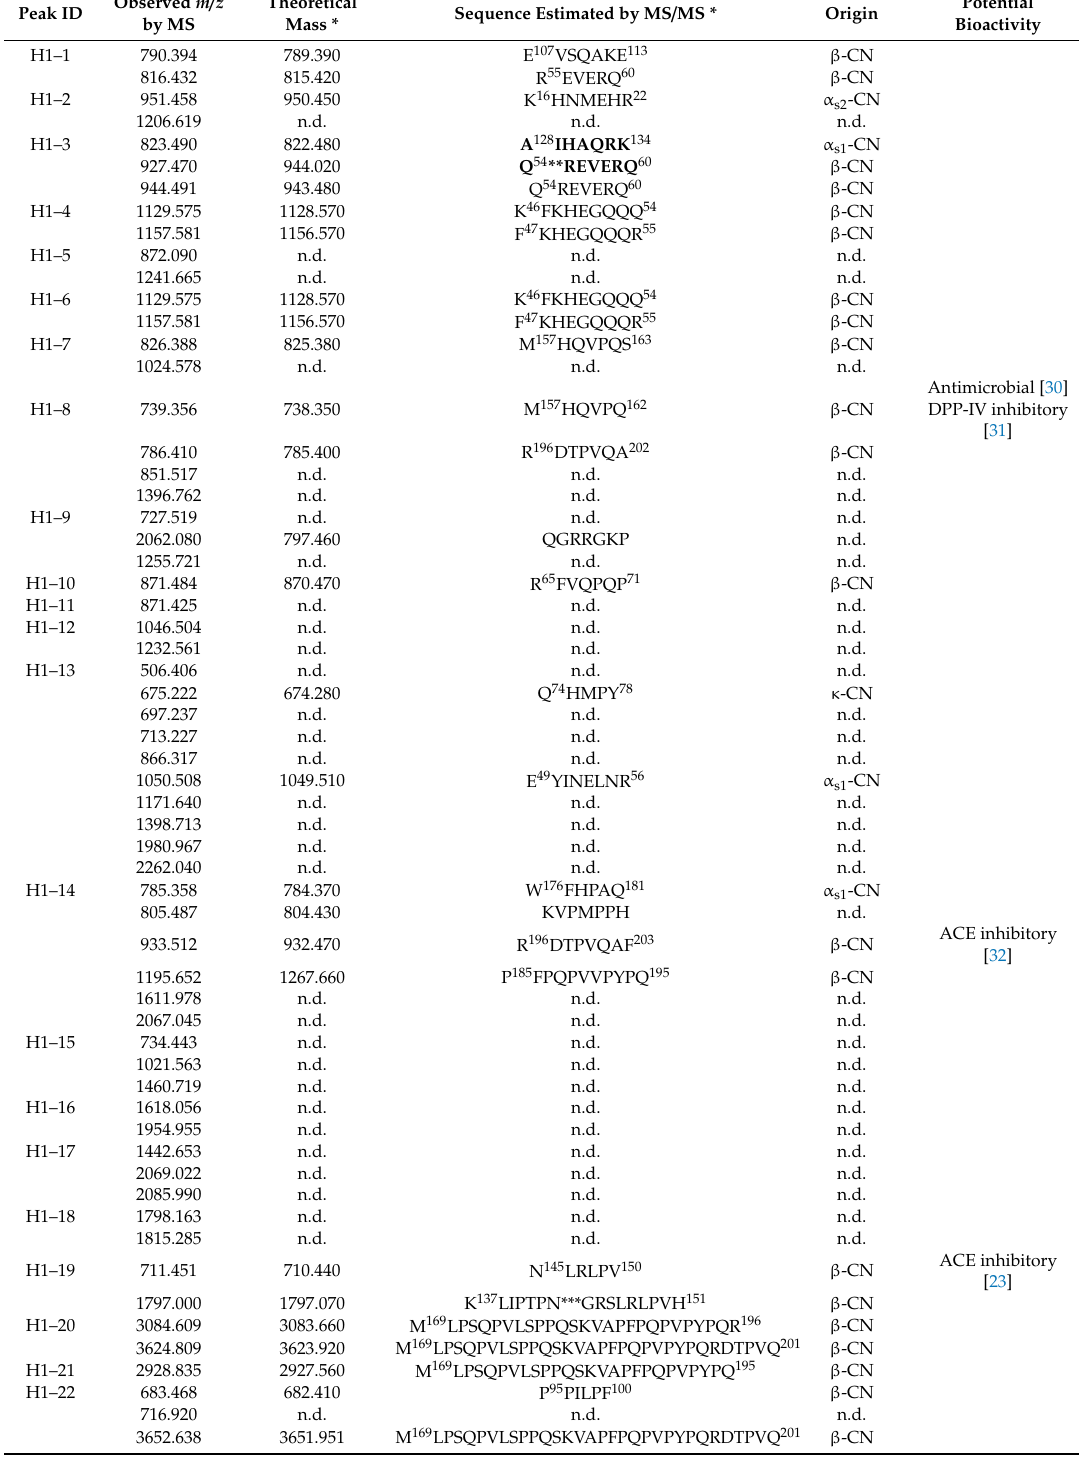
Table 2. Identified peptides in the fermented mare’s milk H1. Observed m / z Theoretical Peak ID by MS Mass